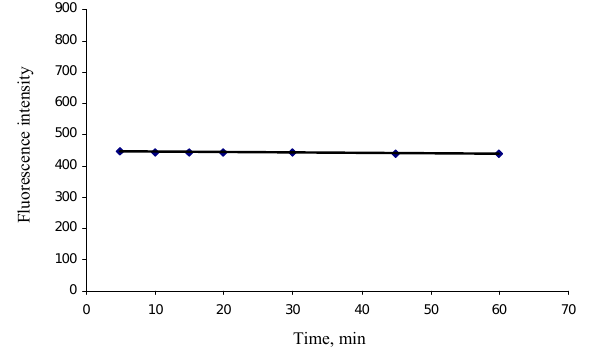
Figure 1. Effect of time on fluorescence intensity